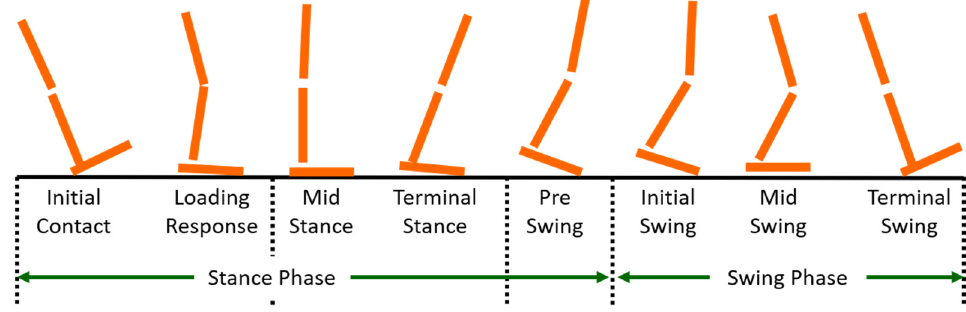
Figure 1. Gait phases.